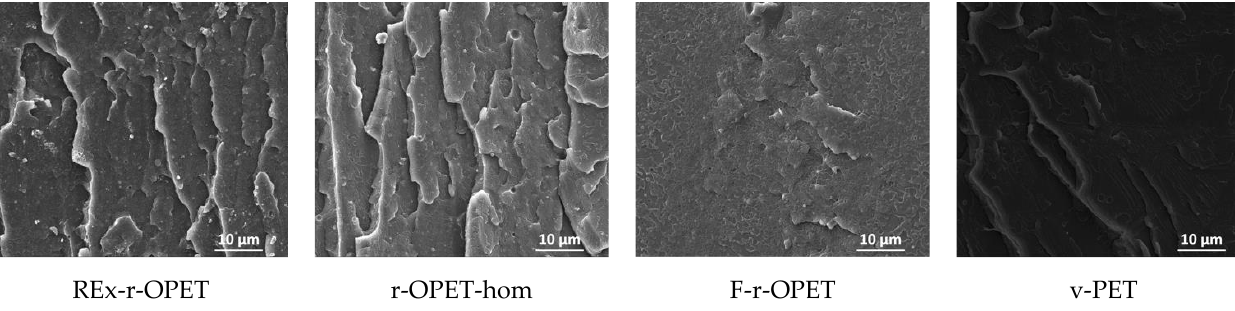
Figure 11. SEM images of cryogenic fracture surfaces of stressed samples during a million cycles.